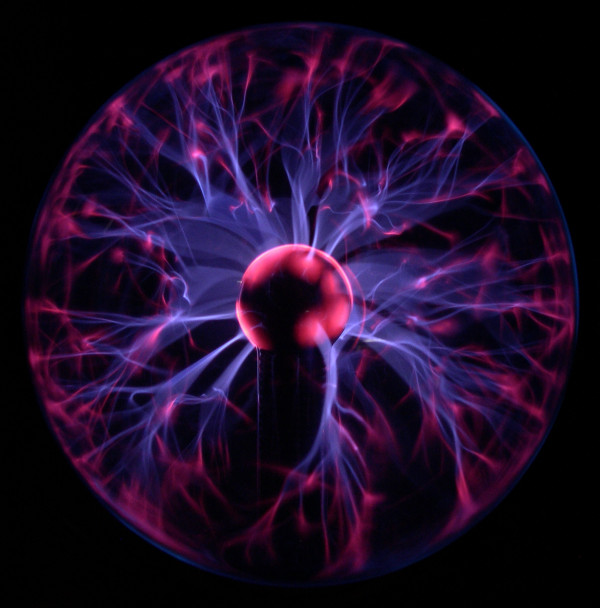
Plasma lamp. The SOFT-NET theory postulates scale-invariance of the self-organizational dynamics of energy/matter at all levels of the organizational hierarchy, from elementary particles through cells and organisms to the Universe as a whole. The presented analysis of empirical data, together with the inferences made on the basis of scale symmetry, suggest that electrons moving between ionized centers in far-from-equilibrium conditions are responsible for key properties of living matter. The plasma lamp conveniently illustrates some of the physical processes and self-organizational patterns that appear to be shared by proteins, cells, organisms, living planets, and plasmas. It should also be mentioned that the hydrated electron was recently proposed to have a similar spatial organization [271]. The image is courtesy of Luc Viatour [272]; see also [260] for more details on plasmas.